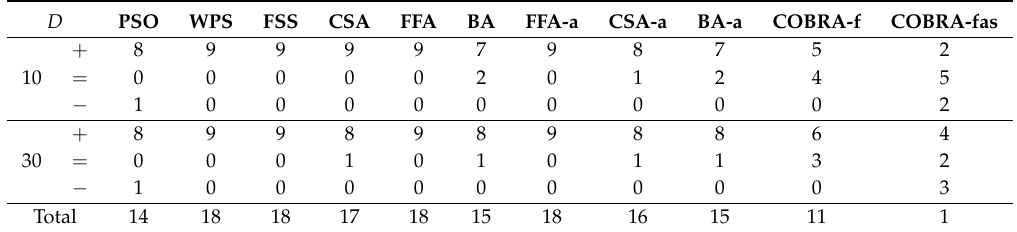
Figure 5. Results of the Mann-Whitney statistical test with p = 0.01, comparison of COBRA-SHA with other approaches (SET-2, D = 30). Table 6. Results of the Mann-Whitney statistical test with p = 0.01 for SET-2, comparison of COBRA-SHA with other